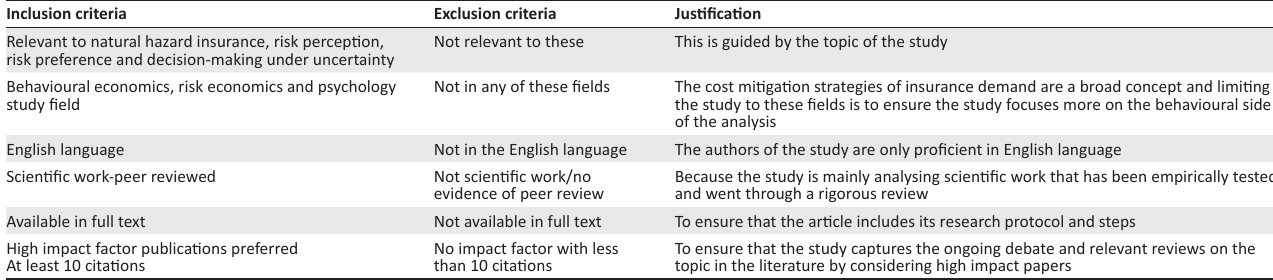
TABLE 1: Inclusion and exclusion criteria. Inclusion criteria